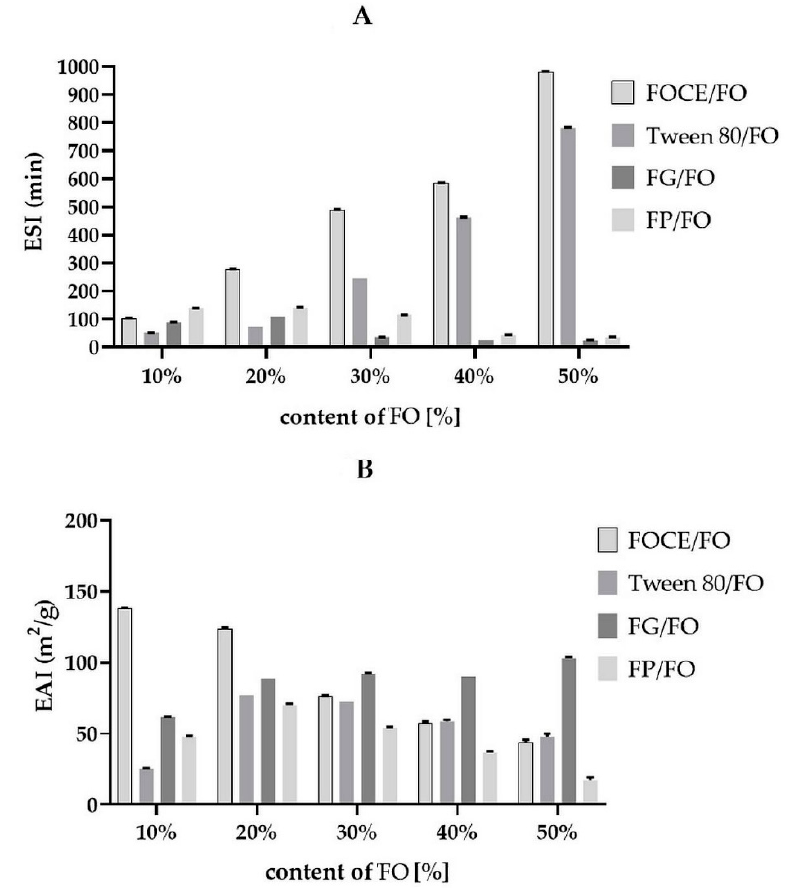
Figure 3. ( A )—Emulsion Stability Index (ESI) of emulsions with FOCE, 3% Tween 80, FP and